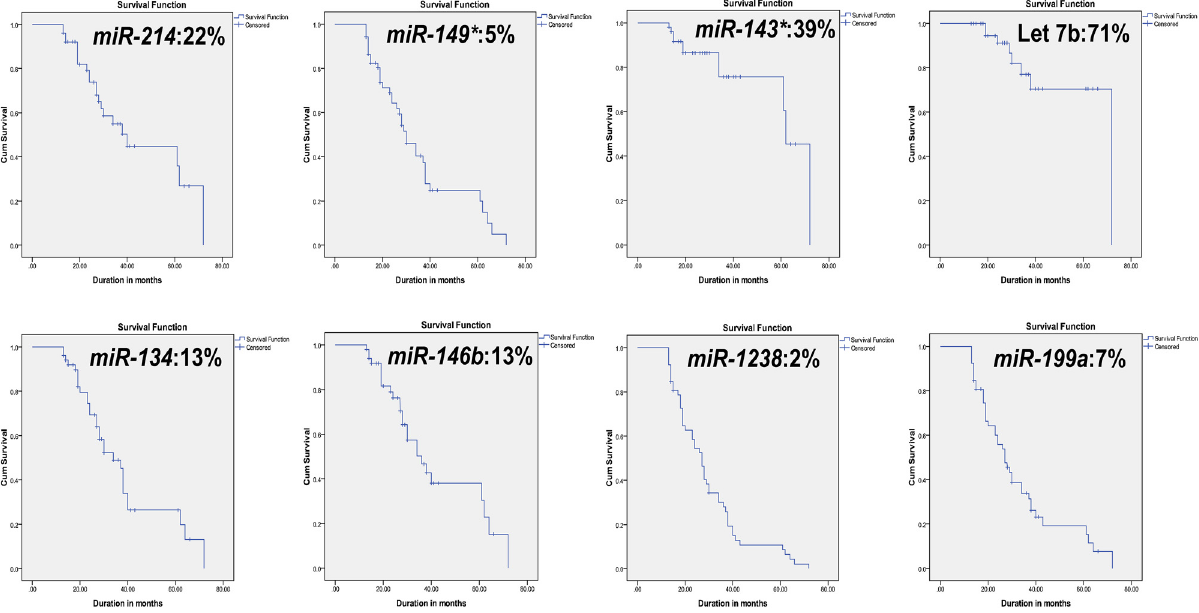
Fig 4. Network interaction between the dysregulated miRNAs and their gene targets in UM. A: D3 UM tumor; B: M3 UM tumor. The network is drawn with the expressions obtained by qRT-PCR using cytoscape v.2.8. Green colour indicates the down-regulation of miRNAs/ genes; red colour indicates the up-regulation of miRNAs/ genes; Yellow colour indicates varied miRNA/ gene